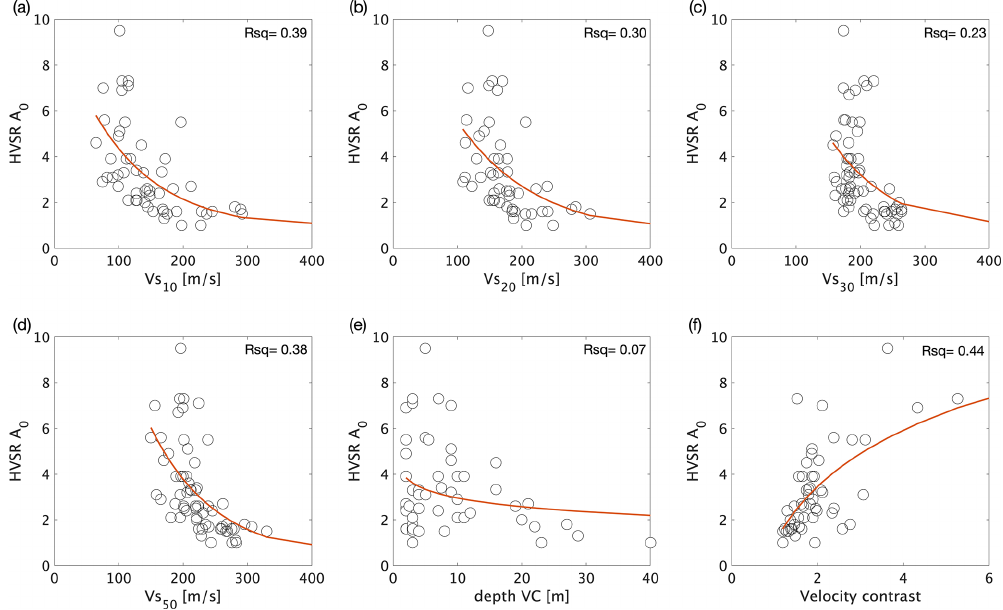
Figure A1. Each panel depicts the fitted function and the coefficient of determination ( R sq ) of the HVSR peak amplitude A 0 per G-network borehole location and the corresponding subsurface parameter. The (a) V s10 , (b) V s20 , (c) V s30 , (d) V s50 , (e) depth of the velocity contrast, and (f) size of the velocity contrast.